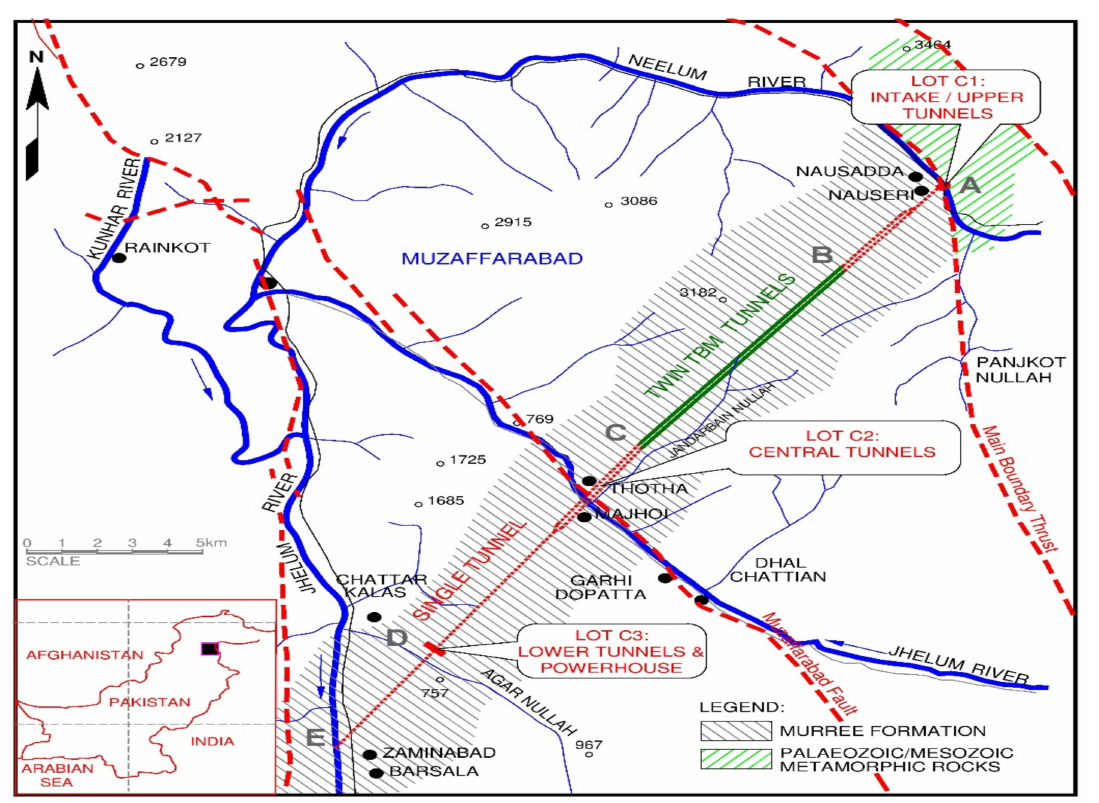
Figure 1. Project